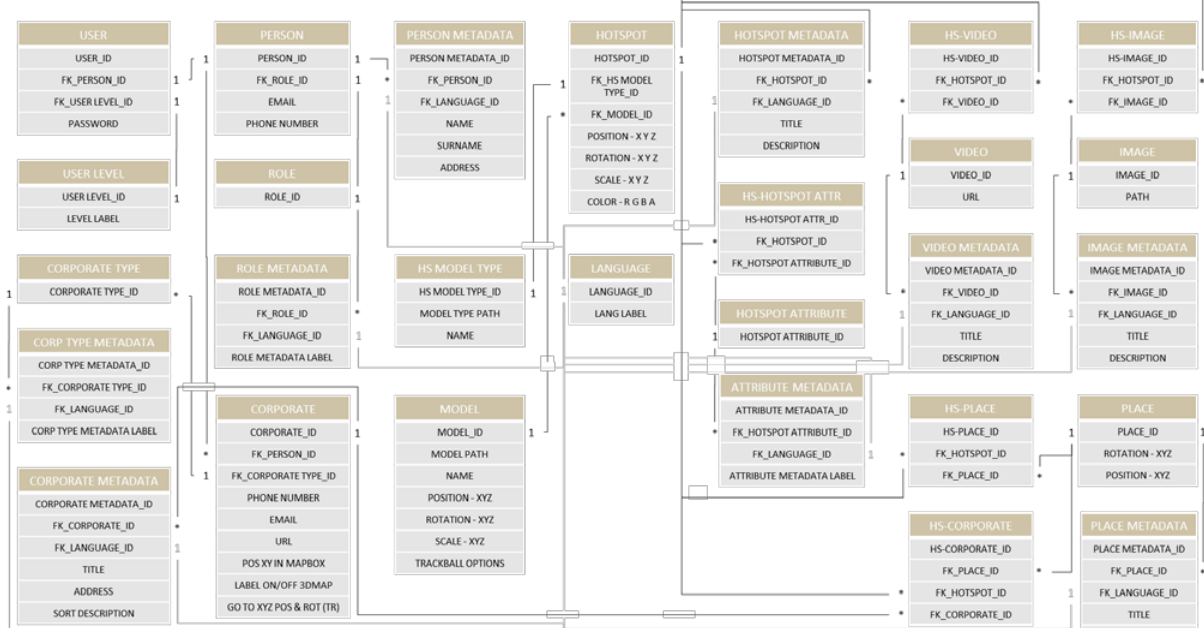
Figure 3. Database relational entity diagram where the structure of tables and the properties of correlations are based on the interactive services of the